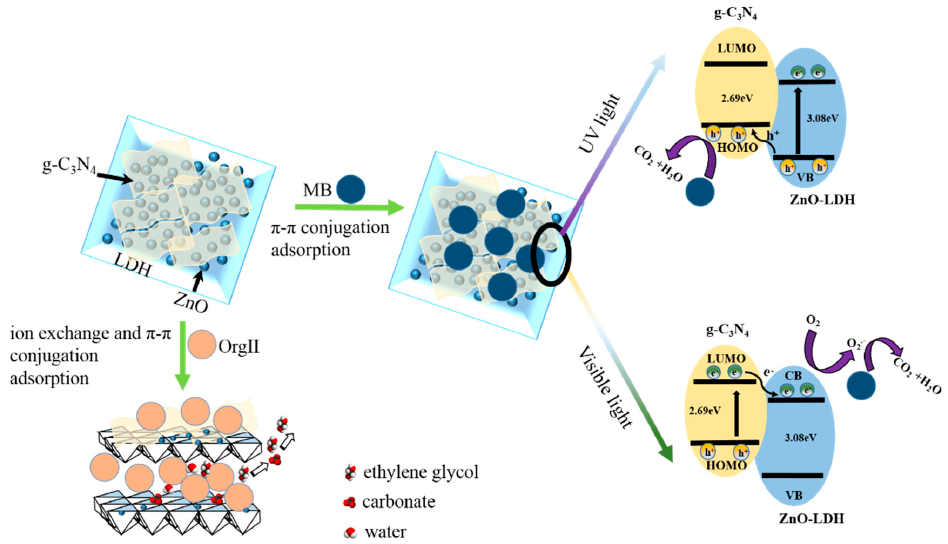
Figure 7. Schematic illustration of the mechanism of uptake of anionic dye OrgII and the charge separation and photocatalytic activity of the ZnO-LDH@C 3 N 4 under UV- and visible-light irradiation, respectively.